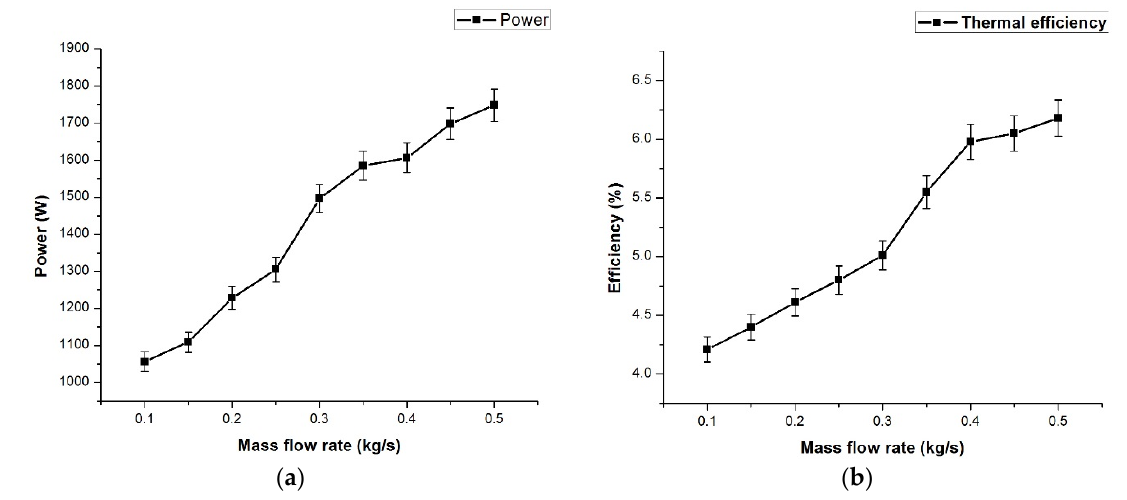
Figure 12. Variation of power produced ( a ) and thermal efficiency ( b ) with mass flow rate of the working fluid.